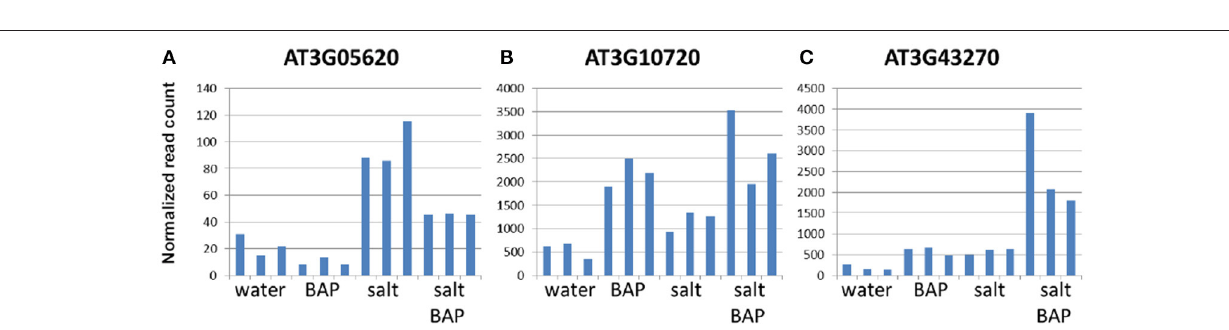
FIGURE 13 | Effect of CK on differential expression of plant invertase/pectin methylesterase inhibitor superfamily genes under salinity stress. (A) AT3G05620 gene expression. (B) AT3G10720 gene expression. (C) AT3G43270 gene expression. Arabidopsis w.t. plants were grown for 30 days in optimal conditions and then leaves were detached and exposed to BAP 10 µ m, 120mM NaCl, or salt plus BAP for 24h. Controls were detached leaves in water. Three samples were collected from the controls and stressed leaves.